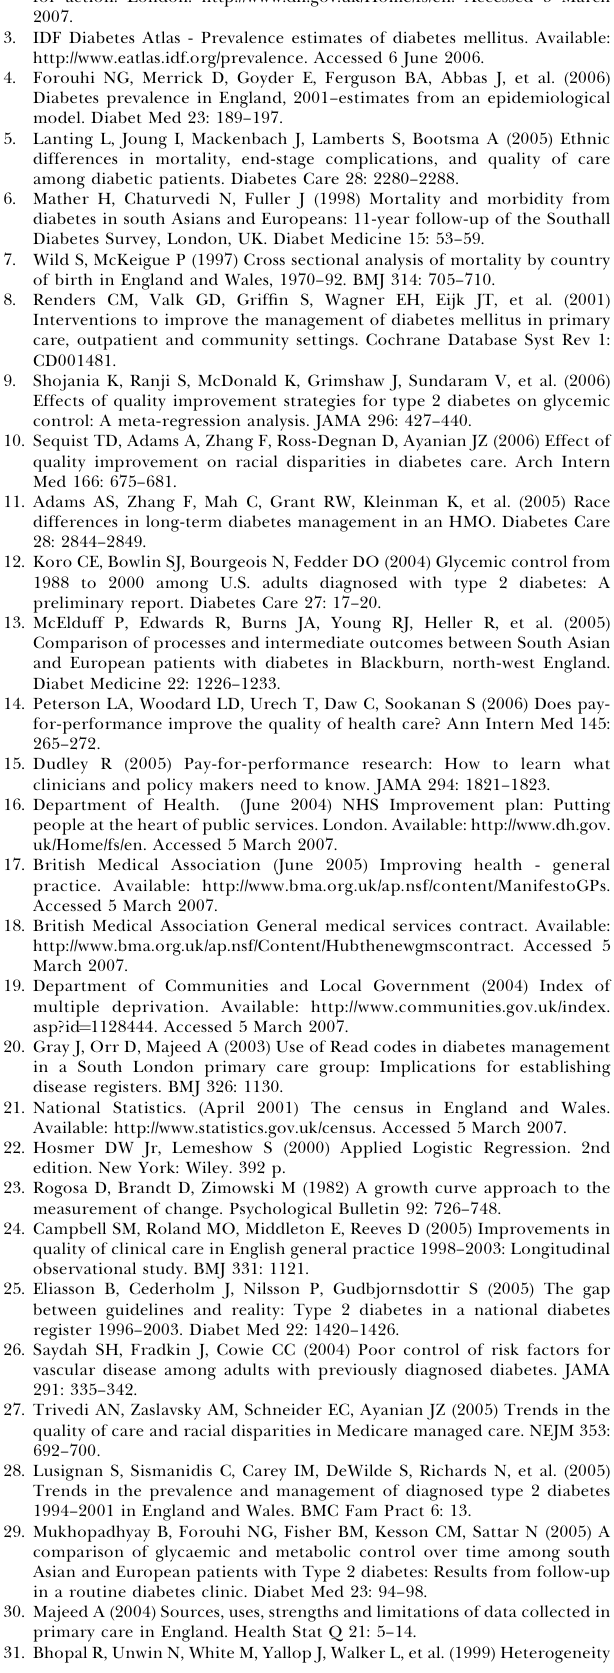
Table S1. Characteristics of